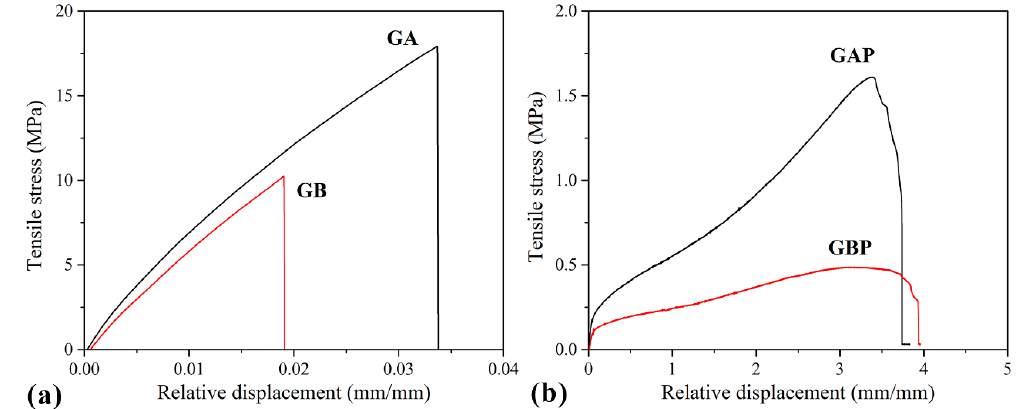
Figure 7. Tensile stress–strain curves of: ( a ) Pure gelatin films (GA and GB); ( b ) films with PRH (GAP and GBP). Table 3. Tensile strength ( σ ), elongation at break ( ε ) and elastic modulus (E) of the prepared films.